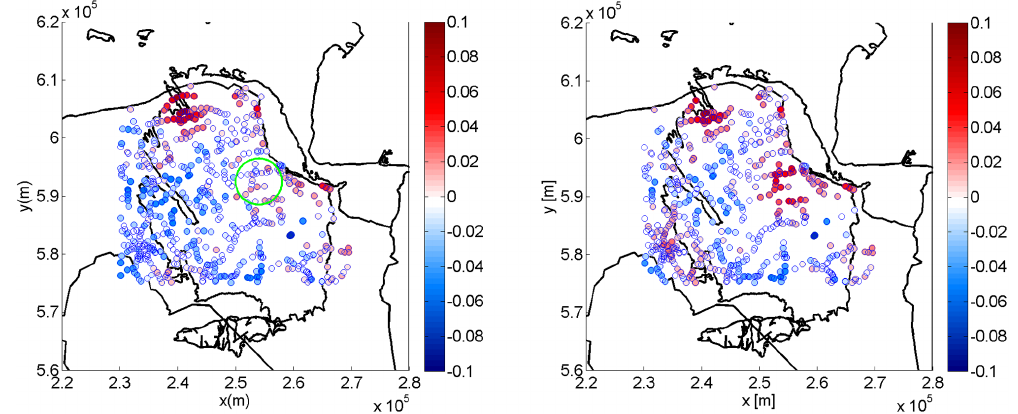
Figure 5. (a) Pattern of misfit (m) in the eastern part of the field, with an adaptation for the porosity of 0.85 applied in the green circle with a radius of 4km. (b) Pattern of misfit (m) using a more active aquifer in the southwestern part of the